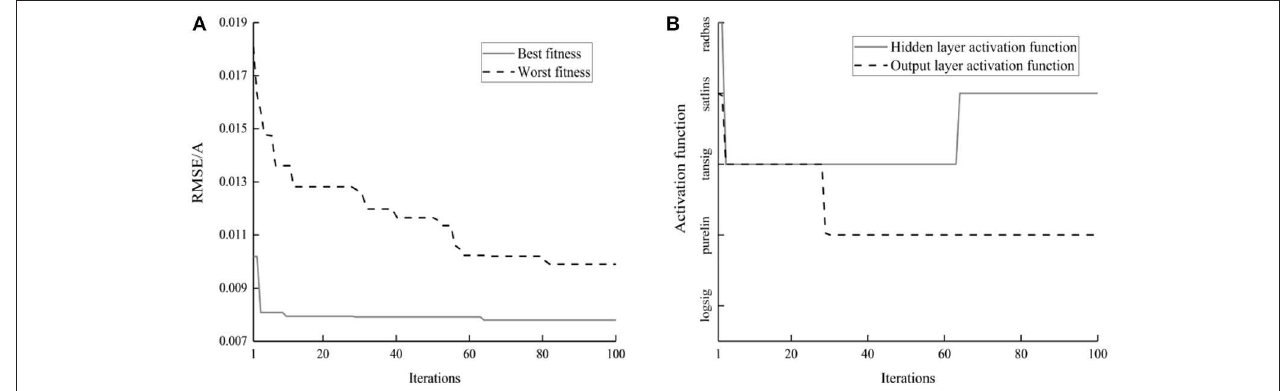
FIGURE 12 | The iteration process of the fitness and activation function in the inverse model. (A) The fitness. (B) The activation